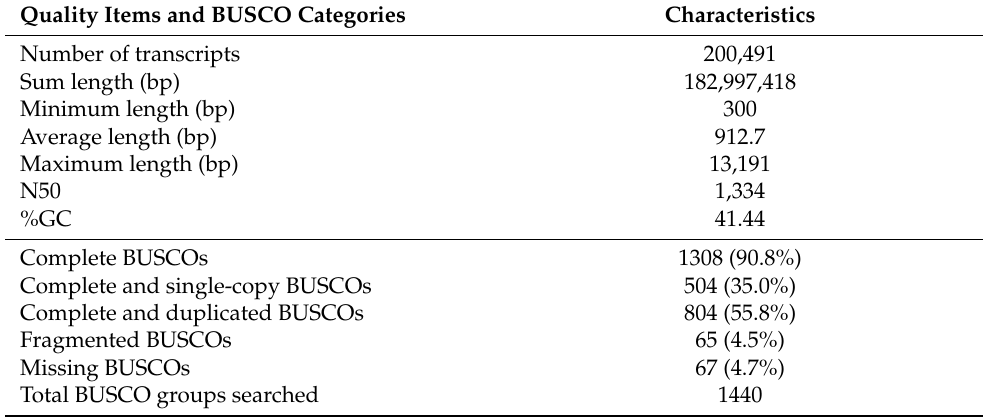
Table 1. Summary of quality assessment of the transcriptome assembly of R. stylosa and BUSCO analysis